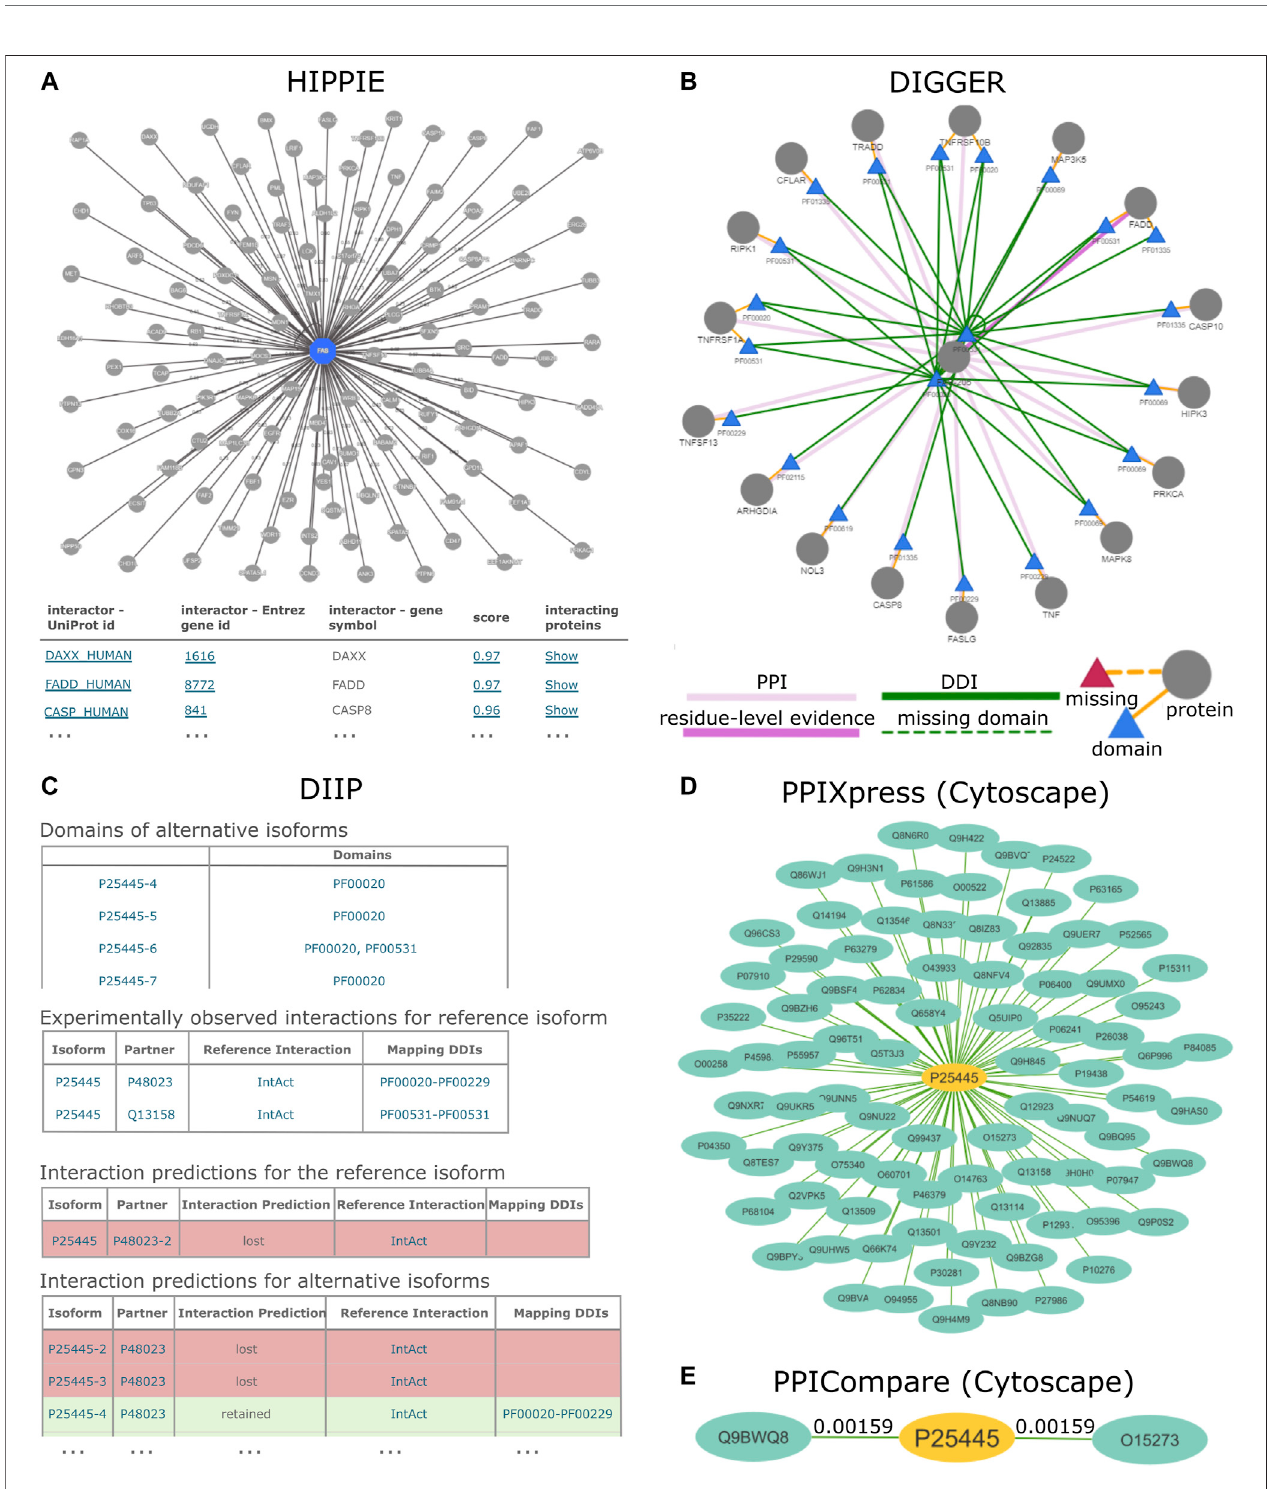
FIGURE 1 | PPI results for the human TNR6 protein encoded by the FAS gene (UniProt accession: P25445) from HIPPIE, DIIP, DIGGER, PPIXpress and PPICompare. (A) HIPPIEpresentsgeneralinteractingpartnersasaPPInetworkviewandatablewithevidencescores. (B) DIGGERpresentsaninteractivePPI-DDIview that combines different aspects of a PPI for a single isoform. The domain and exon architecture view and more detailed results for individual interactions, domains and isoforms are not shown here. (C) DIIP compiles tables with the domains and predicted interaction retention for alternative isoforms. (D) PPIXpress was applied to RPKM expression data of neuronal stem cells and H1 stem cells from the Roadmap Epigenomics project (Kundaje et al., 2015).Shown here are the interaction partners ofTNR6intheresultingneuronal stemcellspeci fi cPPInetwork. (E) PPIComparewassubsequently appliedtocell-speci fi cPPIsgeneratedbyPPIXpresstoproducethe differentialPPInetworkbetweenthetwocelltypes.IllustratedherearetwointeractiongainsinthetransitionfromH1stemcellstoneuronalstemcellswiththerespective adjusted p -value. The graphics for the subnetworks from PPIXpress and PPICompare were generated with Cytoscape.